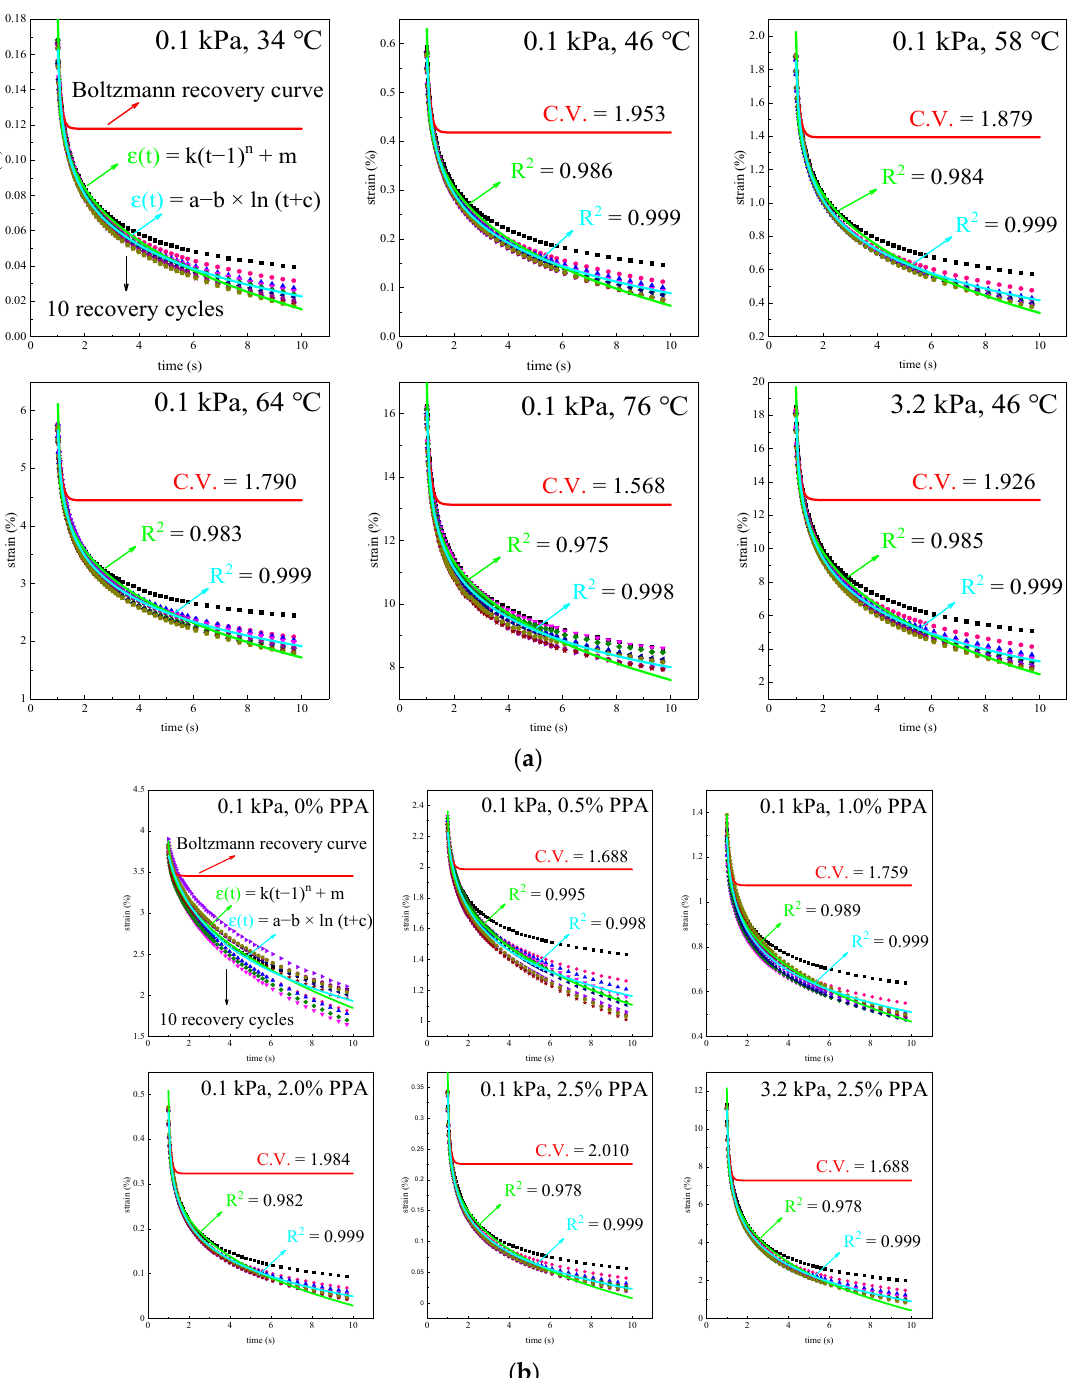
Figure 10. The actual recovery curves and the predicted curves: ( a ) 1.5% PPA at di ff erent temperatures; ( b ) di ff erent PPA dosages at 46 °C .